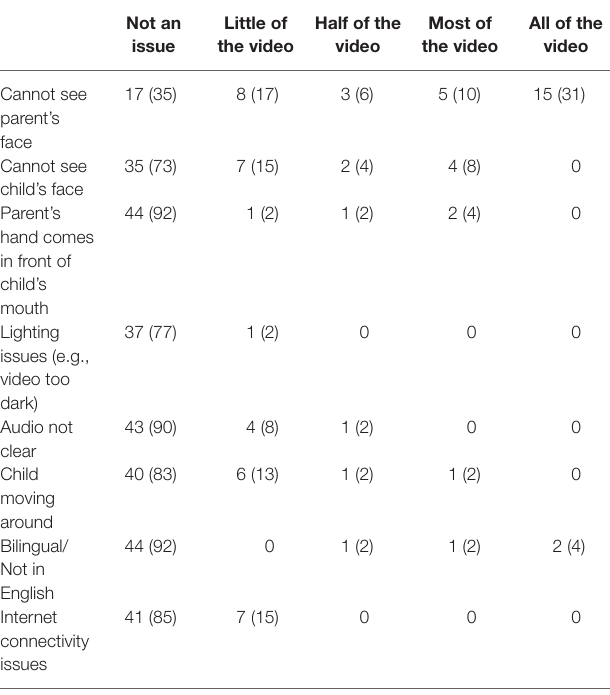
time observations.